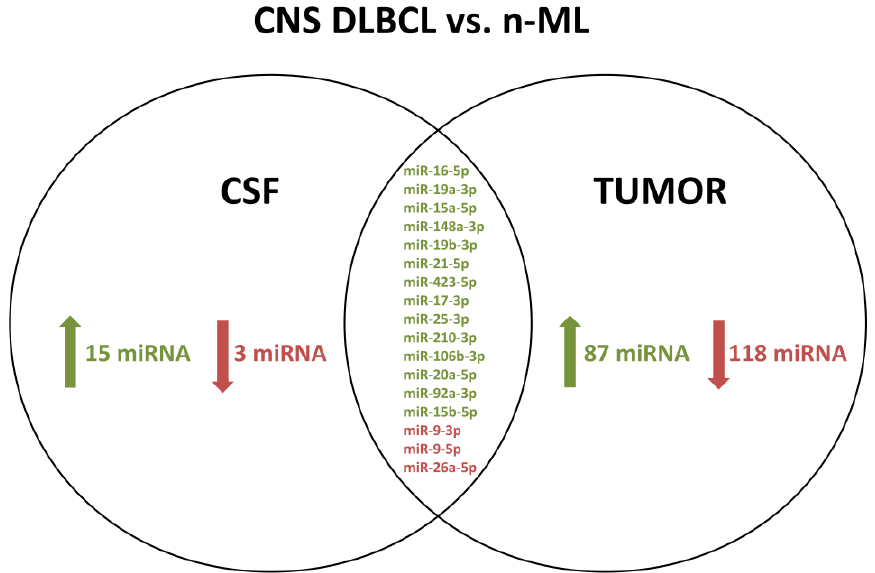
Figure 3. A common set of cerebrospinal fluid (CSF) and tumor microRNAs differentially expressed between patients with primary diffuse large B-cell lymphoma of the central nervous system (CNS DLBCL) and non-malignant CNS diseases (n-ML). Red and green mark miRNAs down- or upregulated in CNS DLBCL vs n-ML.